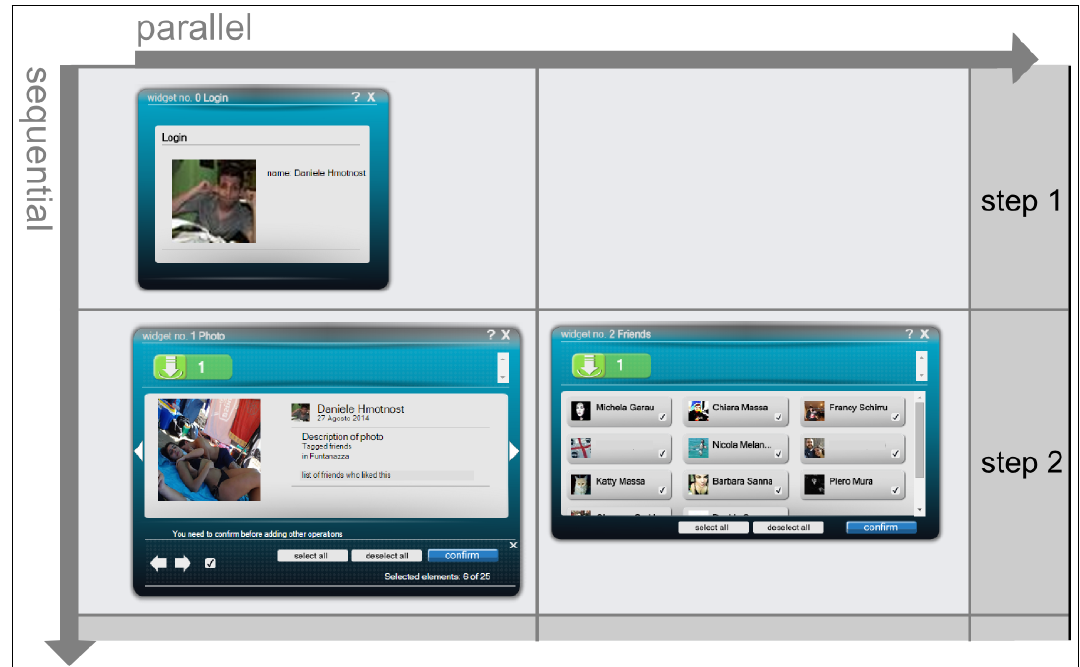
Figure 7. Temporal relationships representation’ in FaceMashup: the sequence with the vertical axis, parallelism with the horizontal axis.